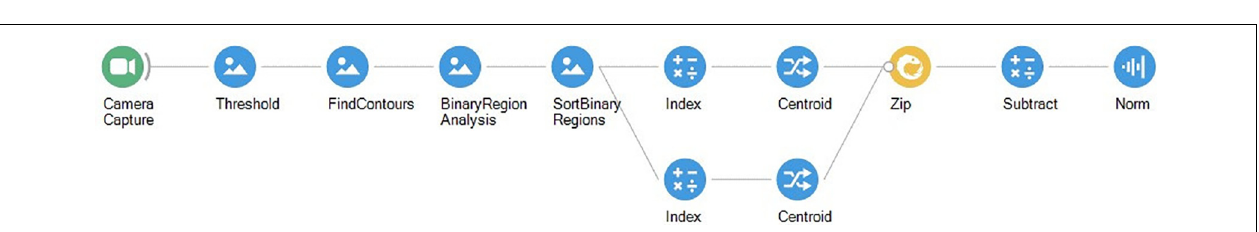
FIGURE 12 | Bonsai workflow for measuring the distance between the two largest